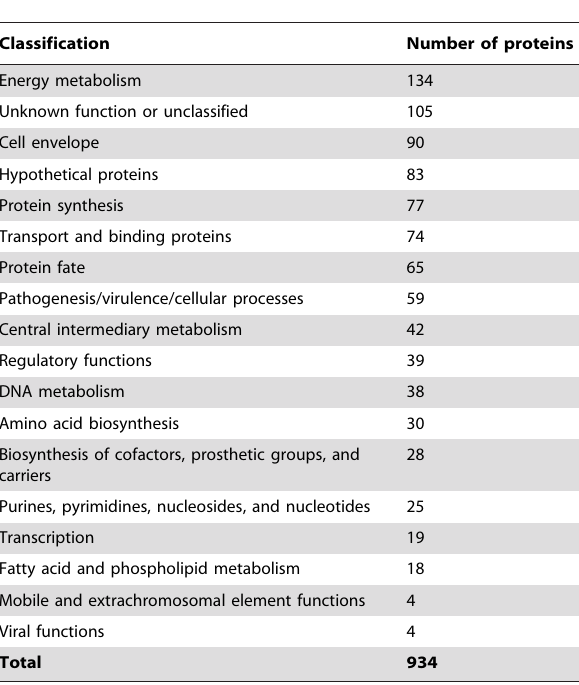
Table 2. Functional categories of proteins detected in S . Typhi membrane